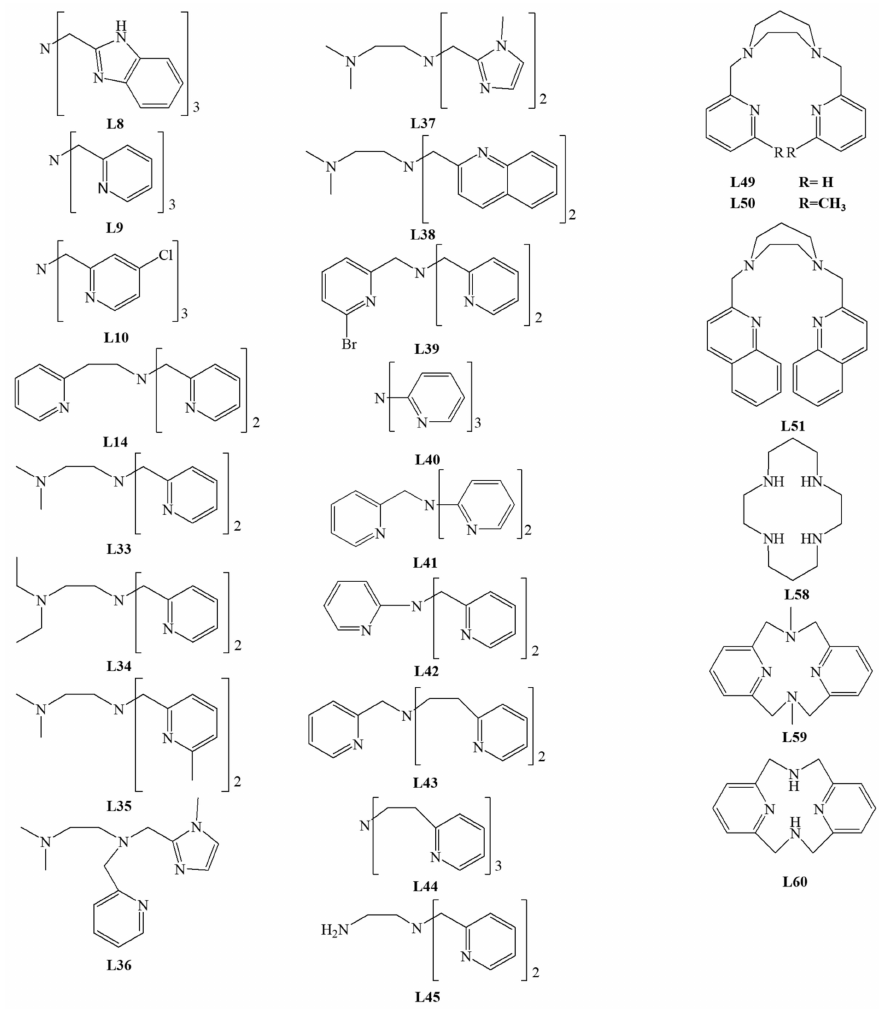
Figure 9. Tetradentate N 4 donor